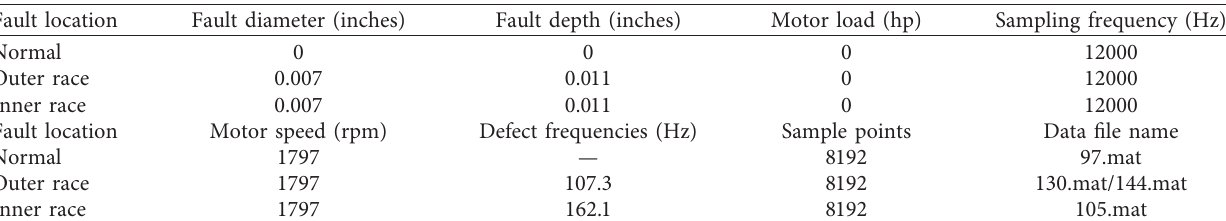
Figure 8: Case Western Reserve University bearing test stand. Table 2: Technical